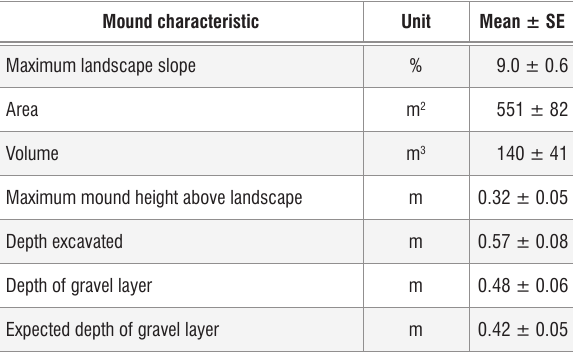
Characteristics of mounds excavated with an auger for which morphological properties were measured ( n =7).